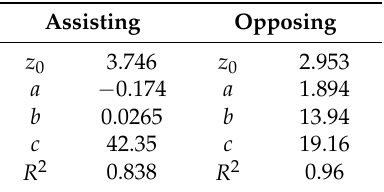
Table 7. Coefficients for the correlations for Ri in the range